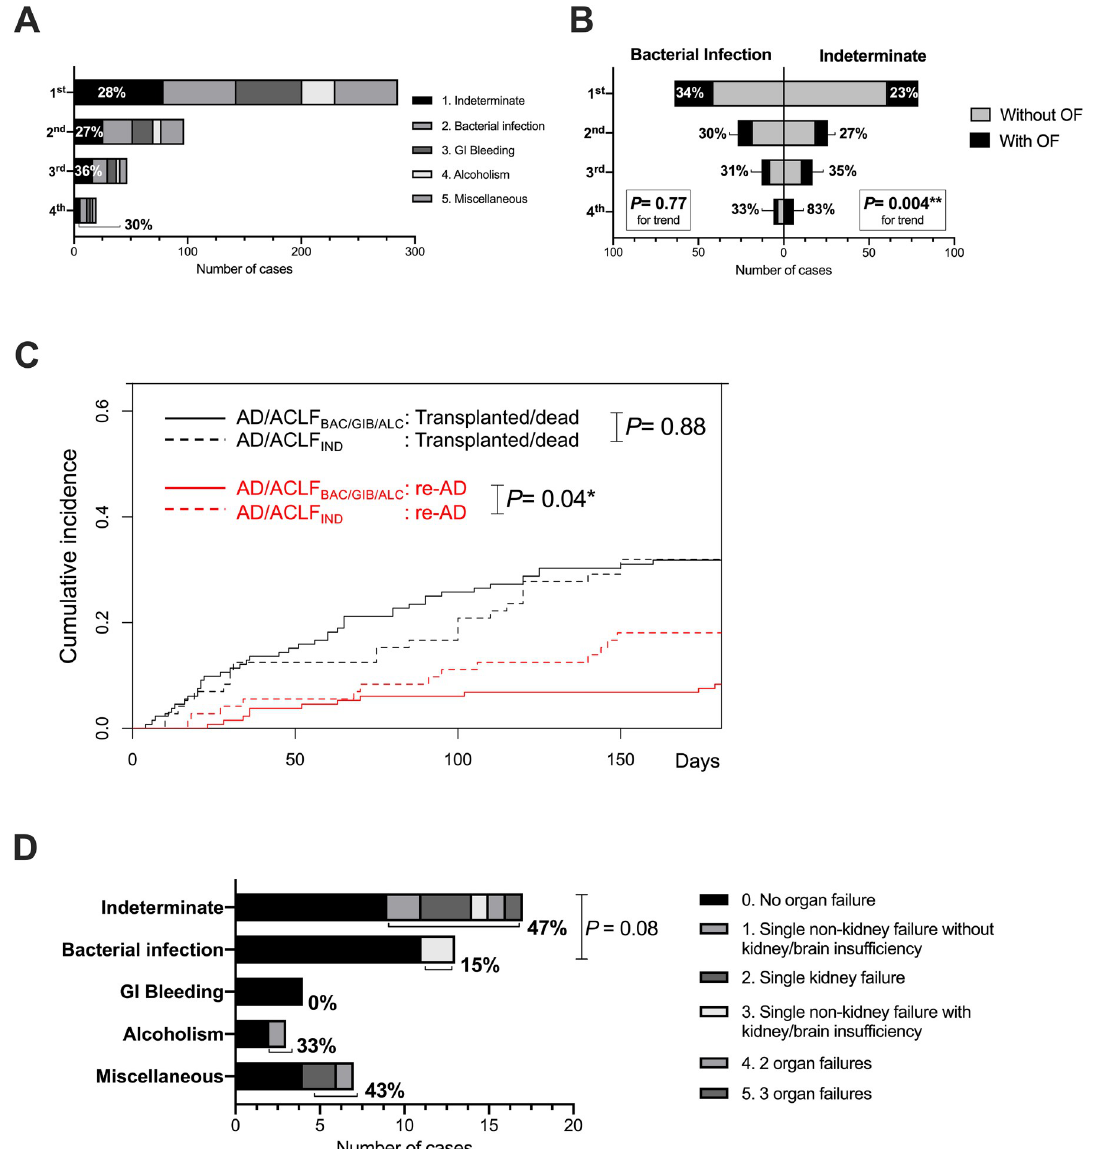
Fig 4. Subsequent re-acute decompensation (re-AD) and AD/ACLF IND . After the first AD/ACLF, the number of subsequent episodes of AD/ACLF was observed. (A) Numbers of cases of acute precipitants are shown in each episode of AD/ACLF separately, with percentages showing AD/ACLF IND . (B) Number of cases and percentages complicated with OF or not are shown in each episode of AD/ACLF separately, comparing AD/ACLF IND and AD/ACLF BAC (left). (C) Competing risk estimates of cumulative incidence function for re-AD (with transplantation or death without transplantation as competing risks) within 180 days are shown. (D) The number of cases and percentages of sub-categories of OFs of the second AD/ACLF are shown by the acute precipitant of their first indexed AD/ACLF. � P < 0.05; �� P < 0.01. ns, not